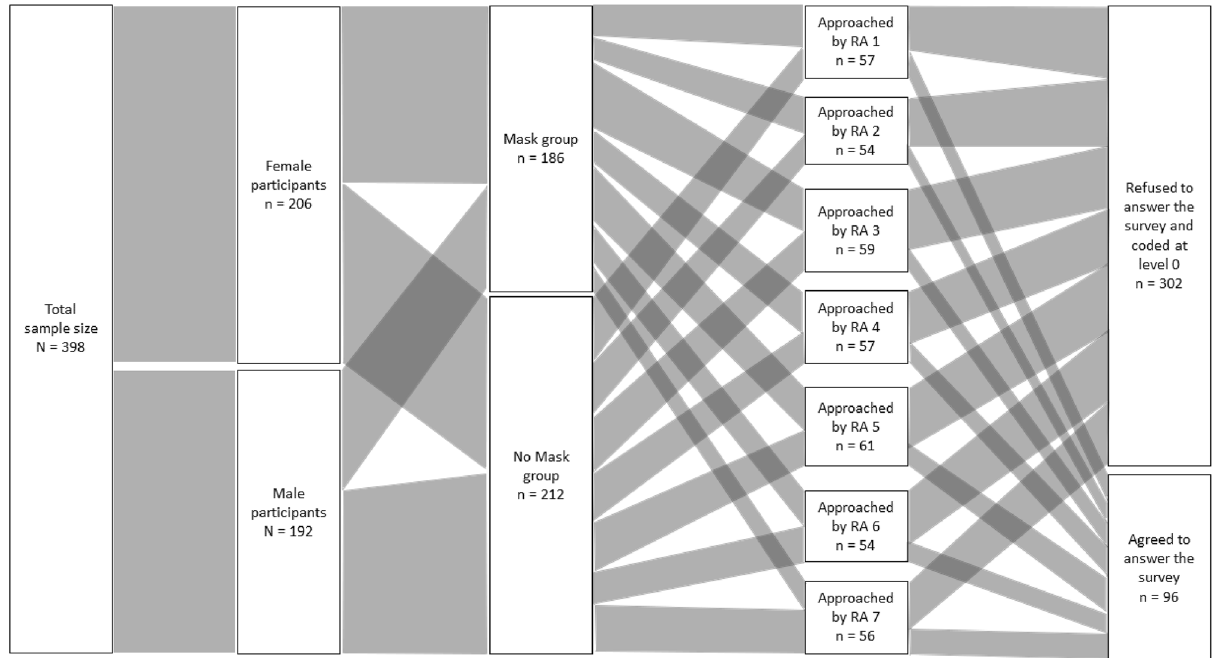
Figure 4. Alluvial diagram of the structure of our sample for study 1. Note This diagram represents the data collection process for the final sample we used in our main analysis. This diagram excludes participants who changed their mask status during the interaction with the research assistant. RA = Research